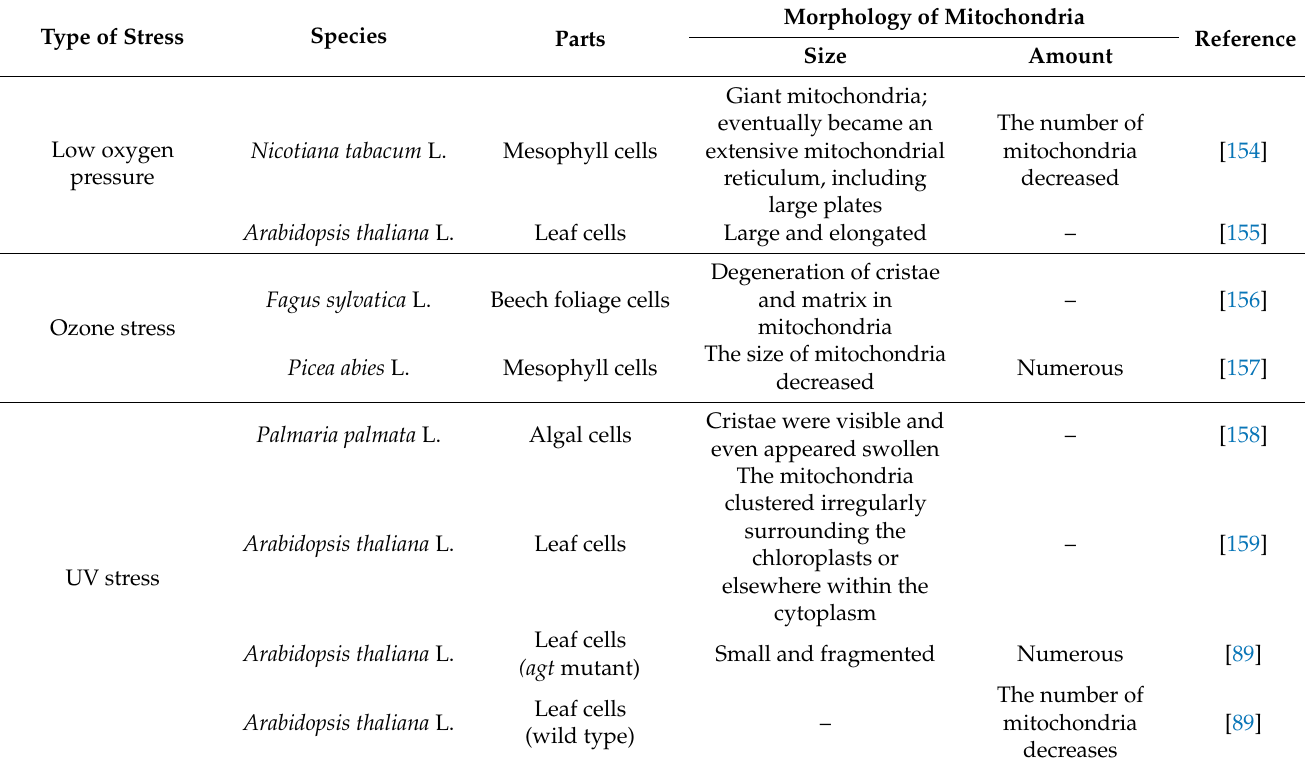
Table 1. Mitochondrial morphological changes under several typical abiotic